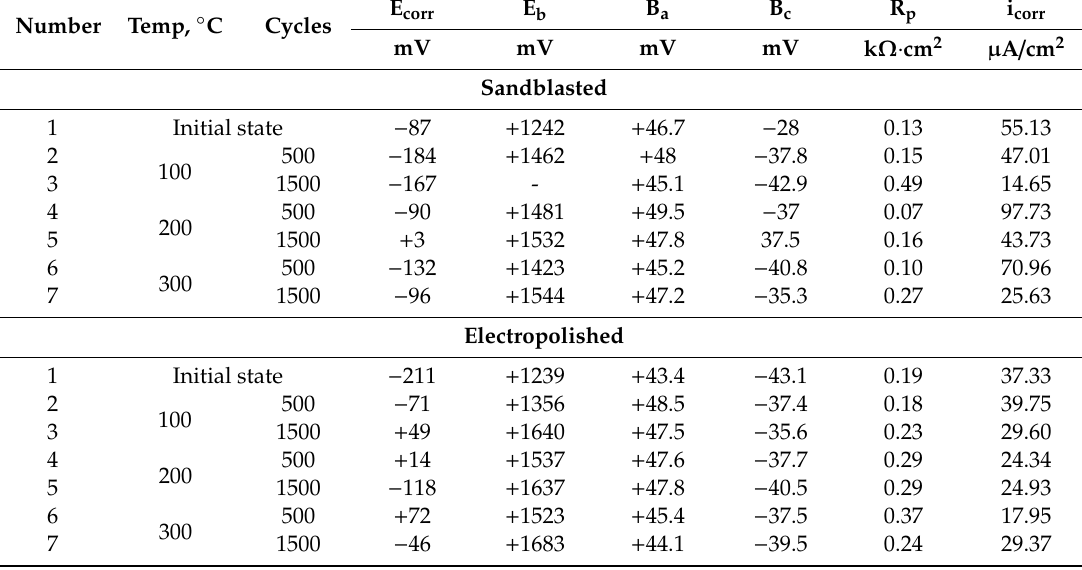
Table 1. Results of the potentiodynamic tests for the surface-modified 316LVM